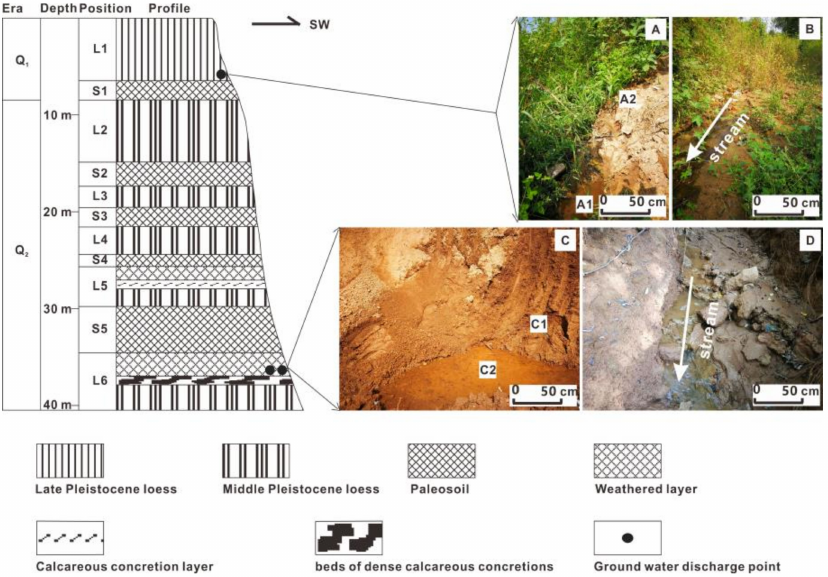
Figure 6. Schematic diagram of the loess strata and groundwater exposure positions of Shaolingyuan in the southern suburbs of